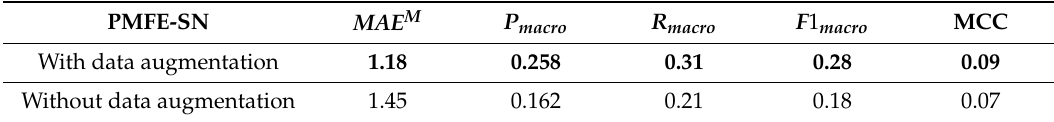
Table 5. Comparison of PMFE-SN with and without data augmentation using MAE M , P macro , R macro , F 1 macro and MCC on leave one cross out testing.